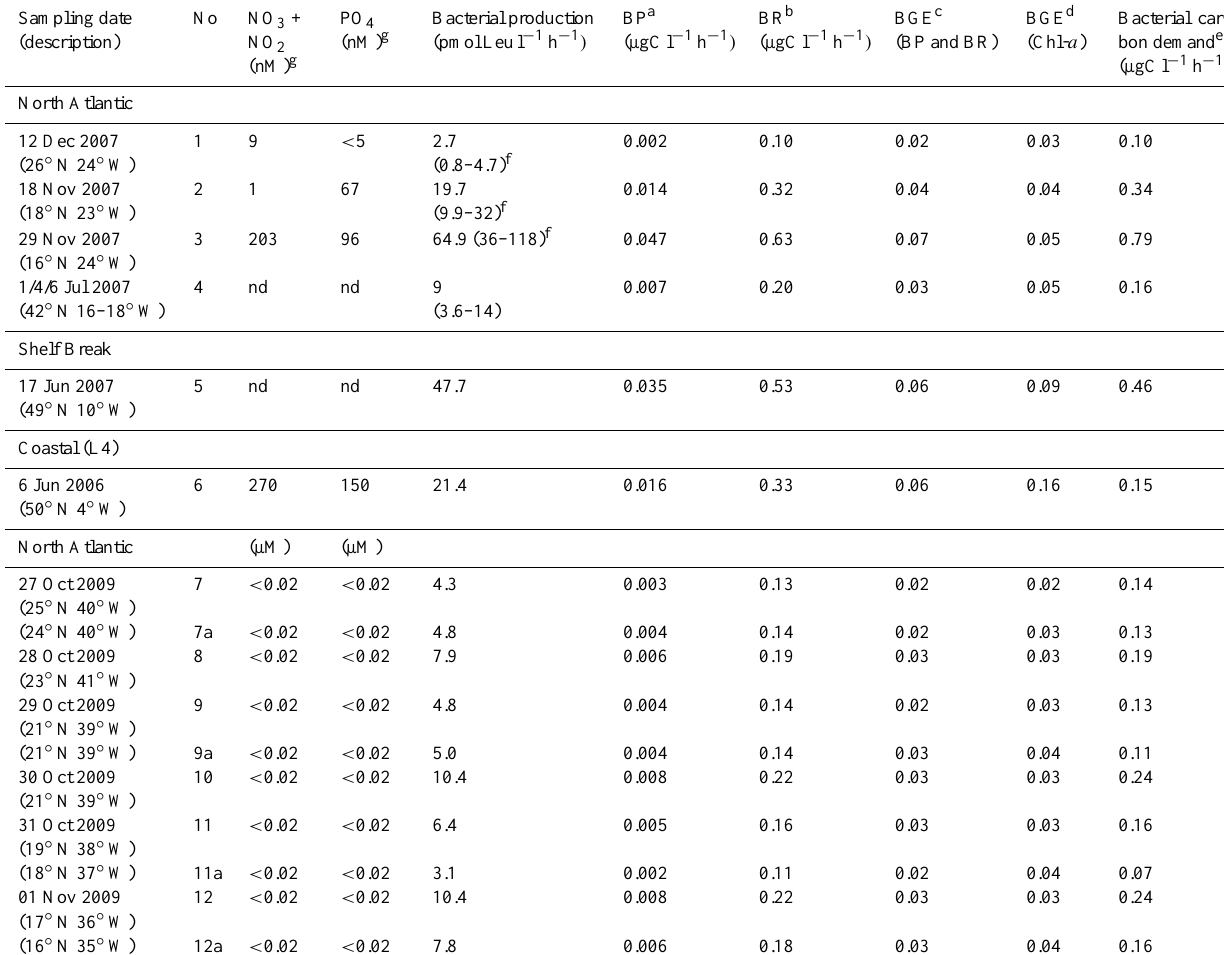
Table 1. Nutrients, bacterial production, respiration, growth efficiency and carbon demand from surface ( ≤ 10m) waters of the eastern North